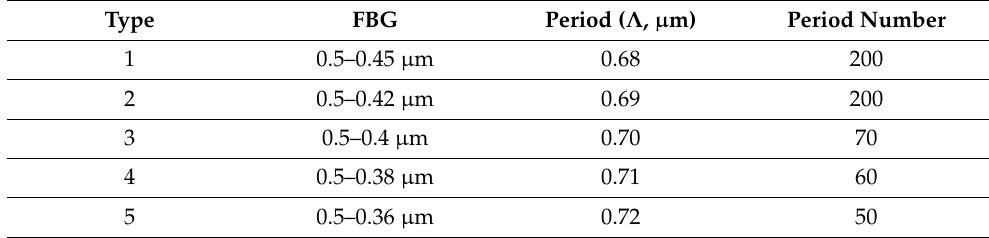
Table 1. The design parameters for the FBG built with the SR.